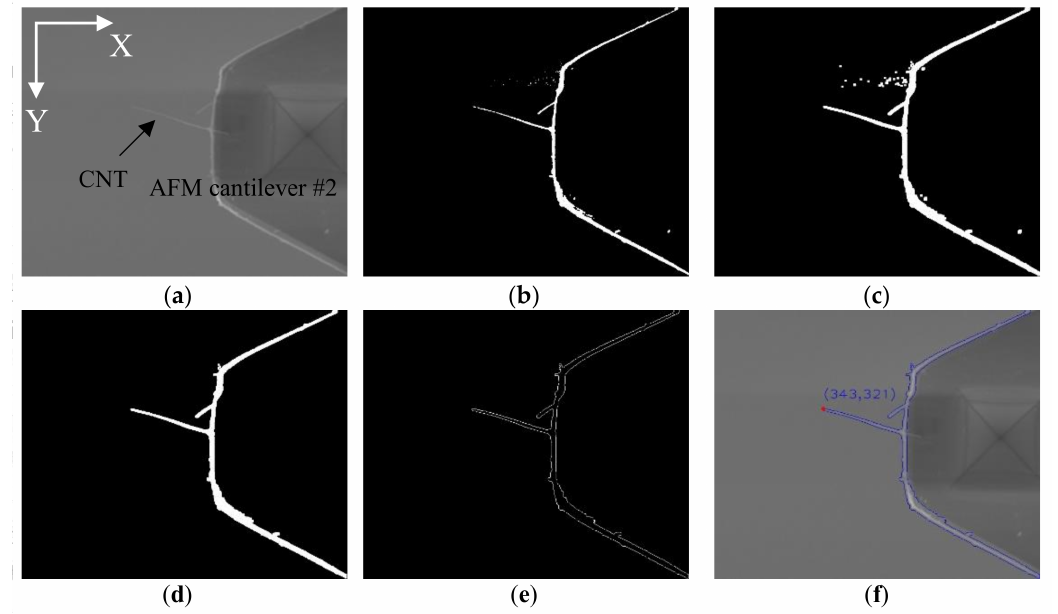
Figure 3. Recognition of CNT tip. ( a ) Raw image; ( b ) Threshold image; ( c , d ) Morphological dilation operations; ( e ) Extracting edge contour of AFM cantilever #2 and CNT; ( f ) Finding the CNT